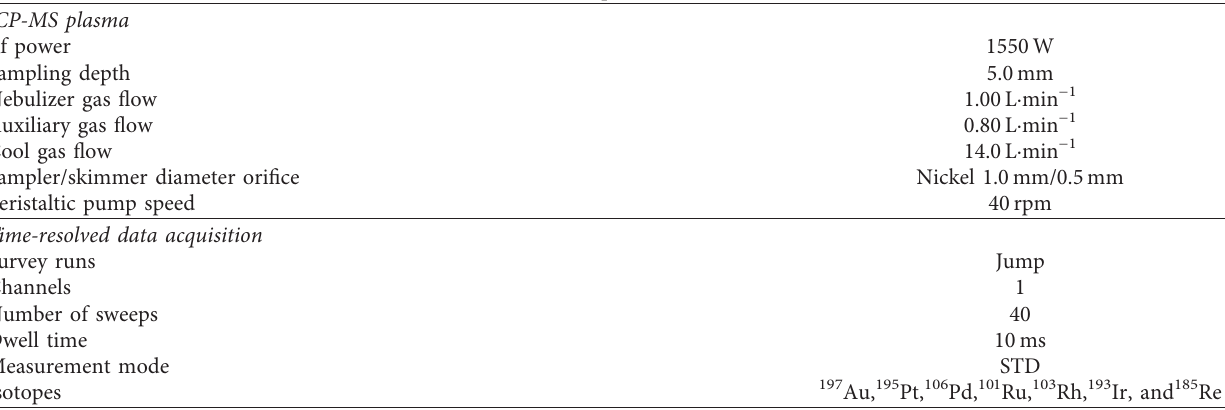
Table 1: ICP-MS operation